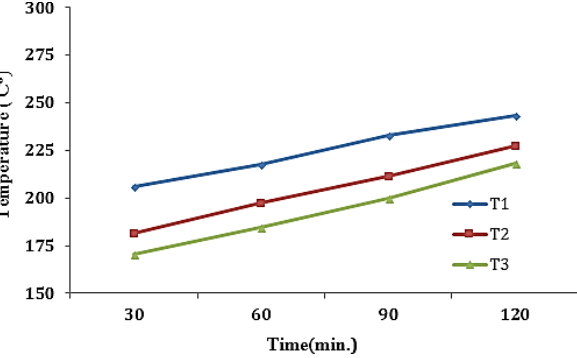
Figure 7: The temperature distribution of (TiN/Al 2 O 3 /TiCN) speci- men at a constant source temperature of 300 ∘